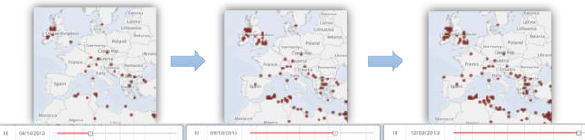
Figure 3 Dynamic event presentation map by using horizontal time axis